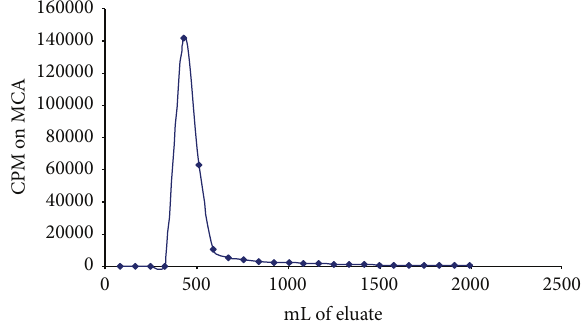
Figure 6: Elution profile for 99 Mo elution from the Al 2 O 3 column with 1M NH 3 using the parameters shown in Table